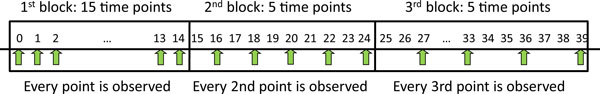
A time point schedule on unequally spaced time series data in the Monte Carlo experiment. Observed points in the time schedule are indicated by arrows. 15 time points are equally spaced in first block, every second point is observed in second block comprised of 5 observed time points, and every third point is observed in third block comprised of 5 observed time points.